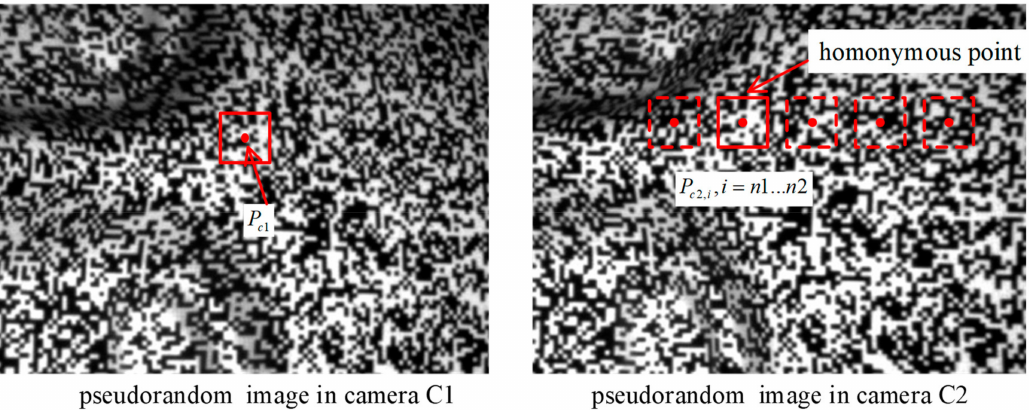
Figure 4. Possible corresponding point pairs between cameras C1 and